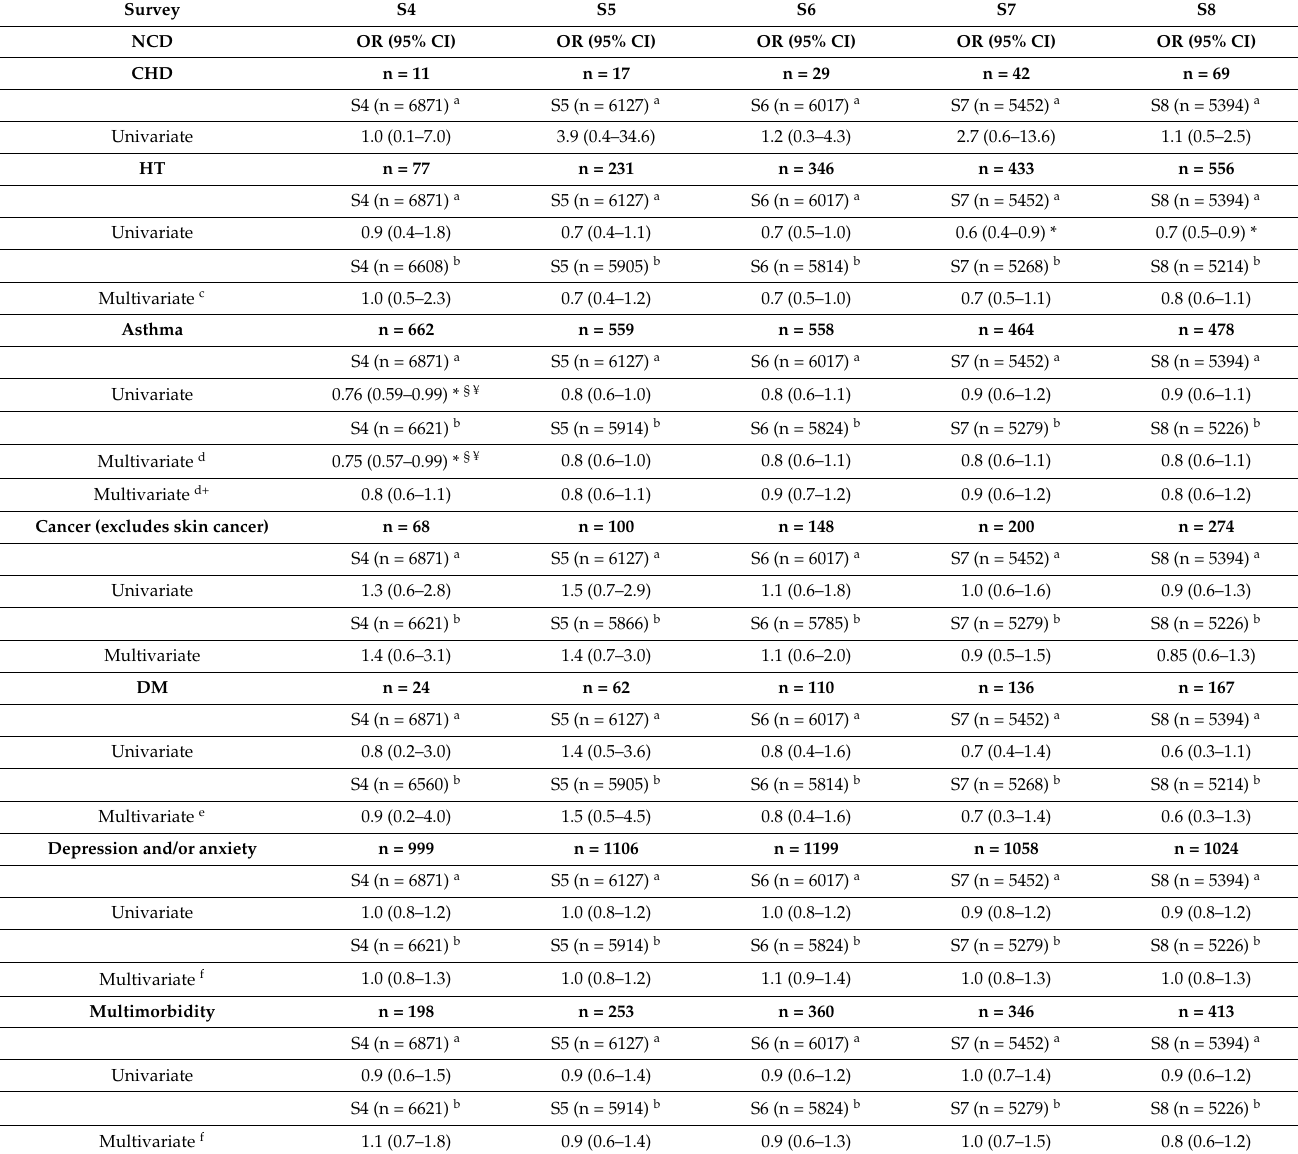
Table 2. Odds of common non-communicable diseases (including multimorbidity) over 15 years of follow-up (from survey 4, S4 to survey 8, S8) based on quintiles of Alternative Healthy Eating Index-2010: 1973–78 Australian Longitudinal Study on Women’s Health